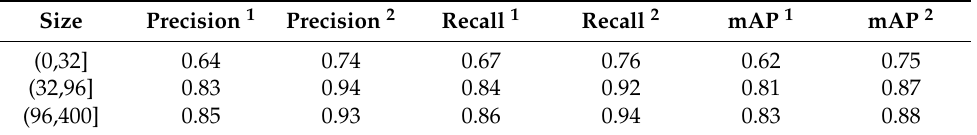
Table 3. YOLOv3 and Improved YOLOv3 Test Results for Targets at Different Sizes